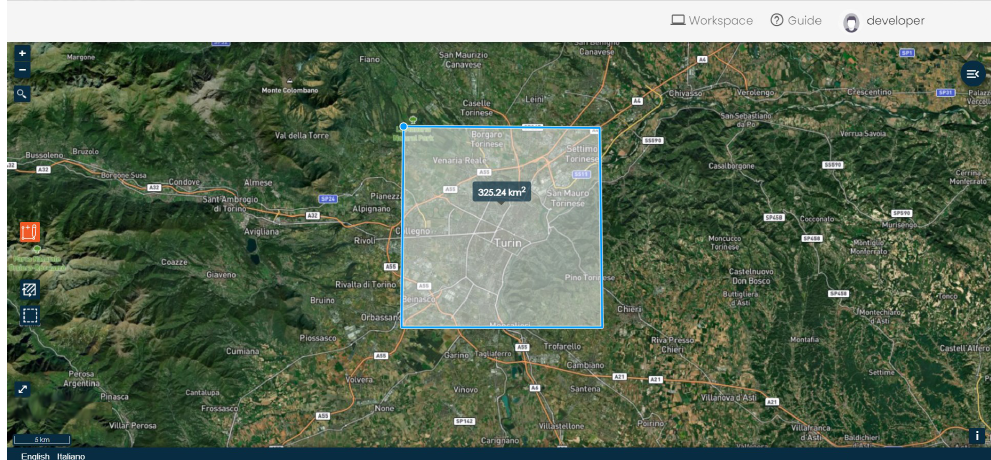
Figure 2. Example of the area of interest selection in the proposed